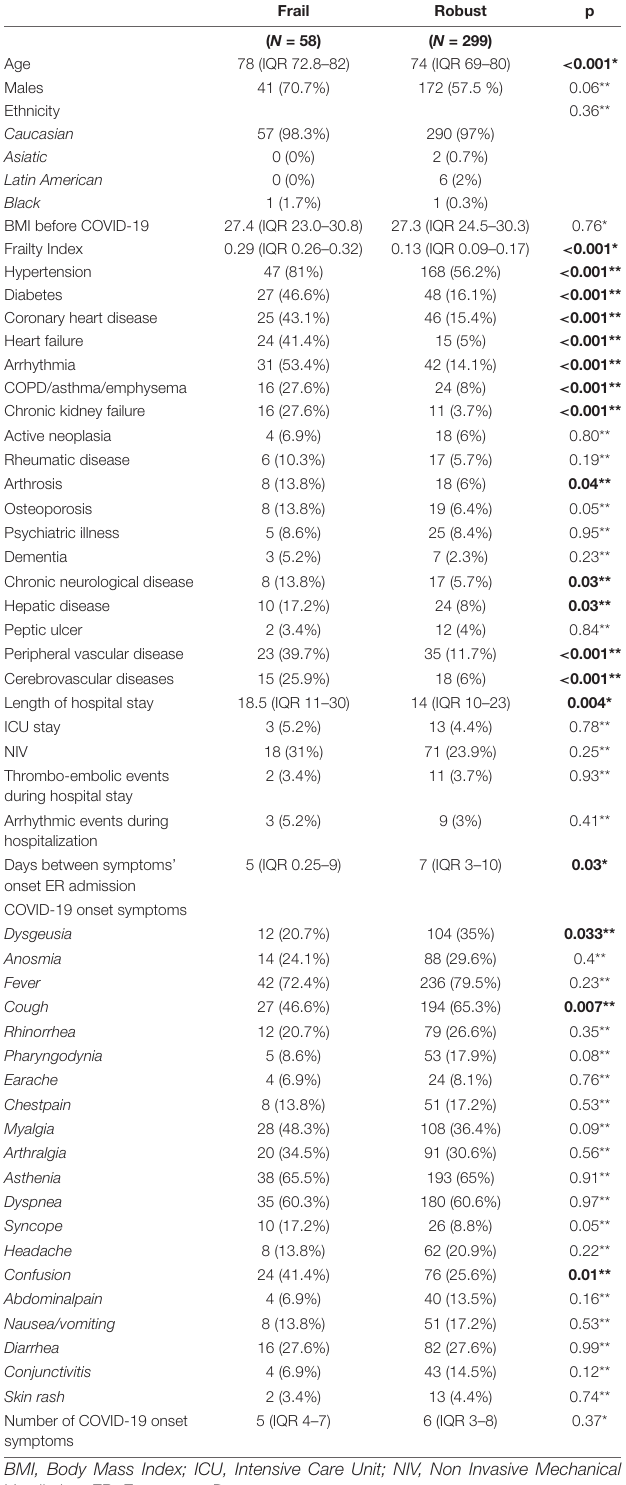
TABLE 1 | Baseline and hospitalization characteristics of the study population #